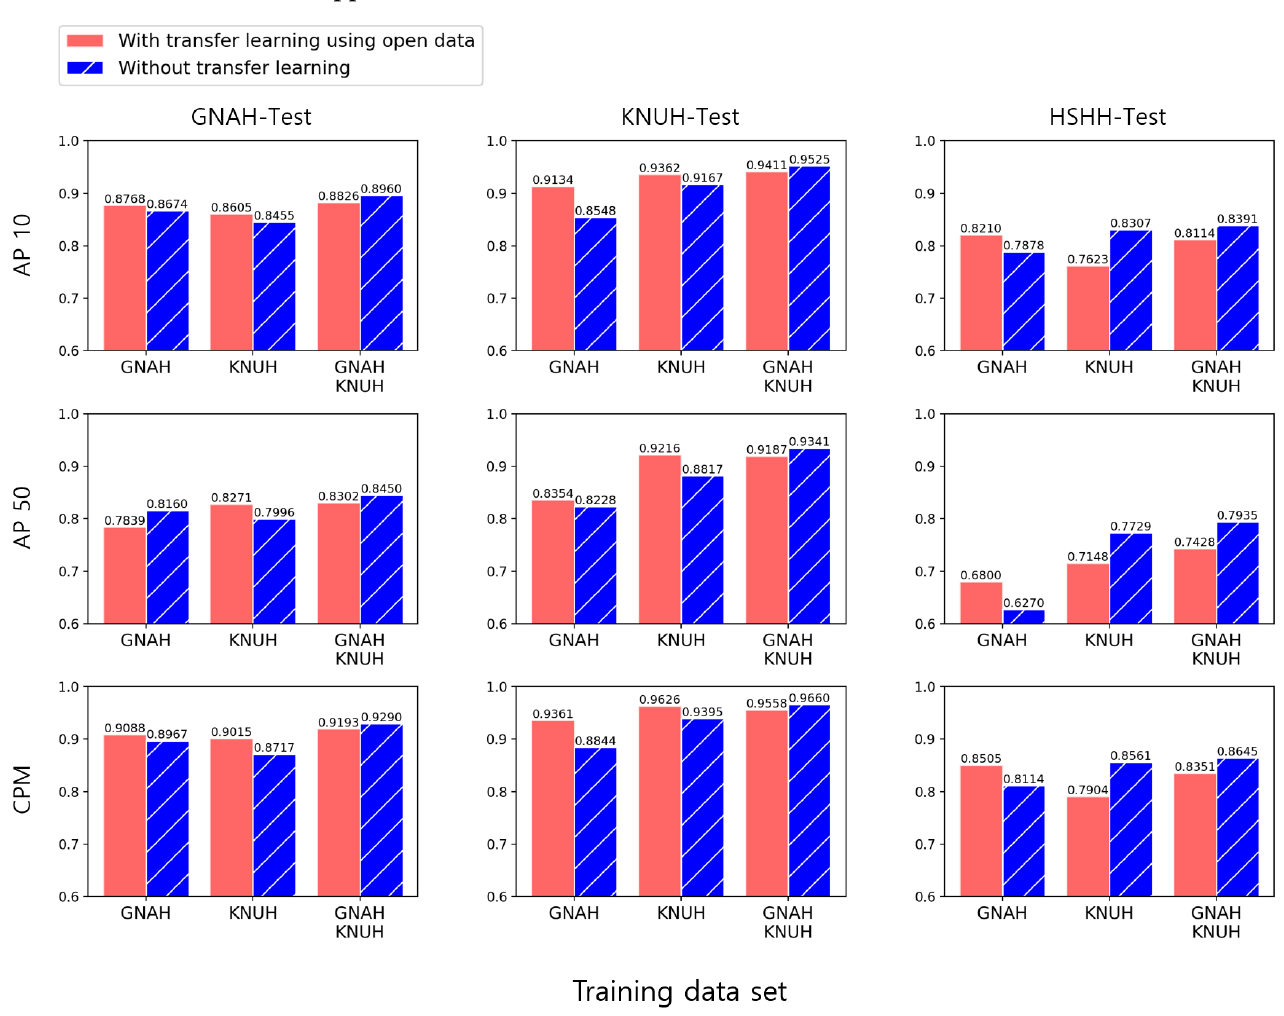
Figure A1. Experiment 2.